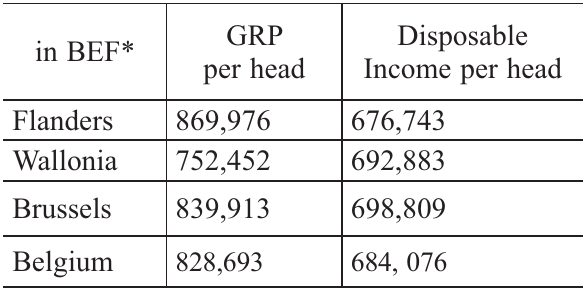
Table 7. Income Paradox in Belgium